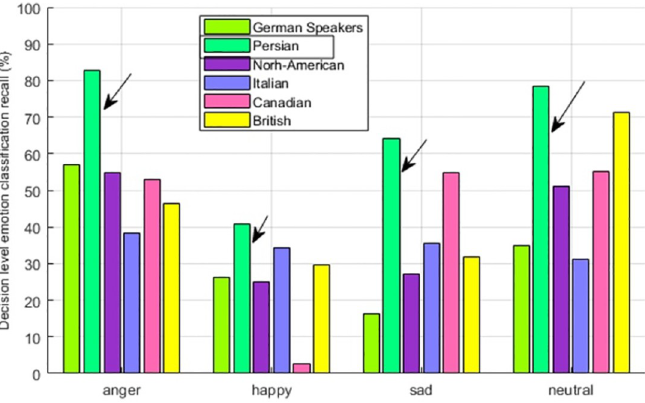
Fig 12. Persian speaker—Multicultural emotion recall comparison and In-group advantage.